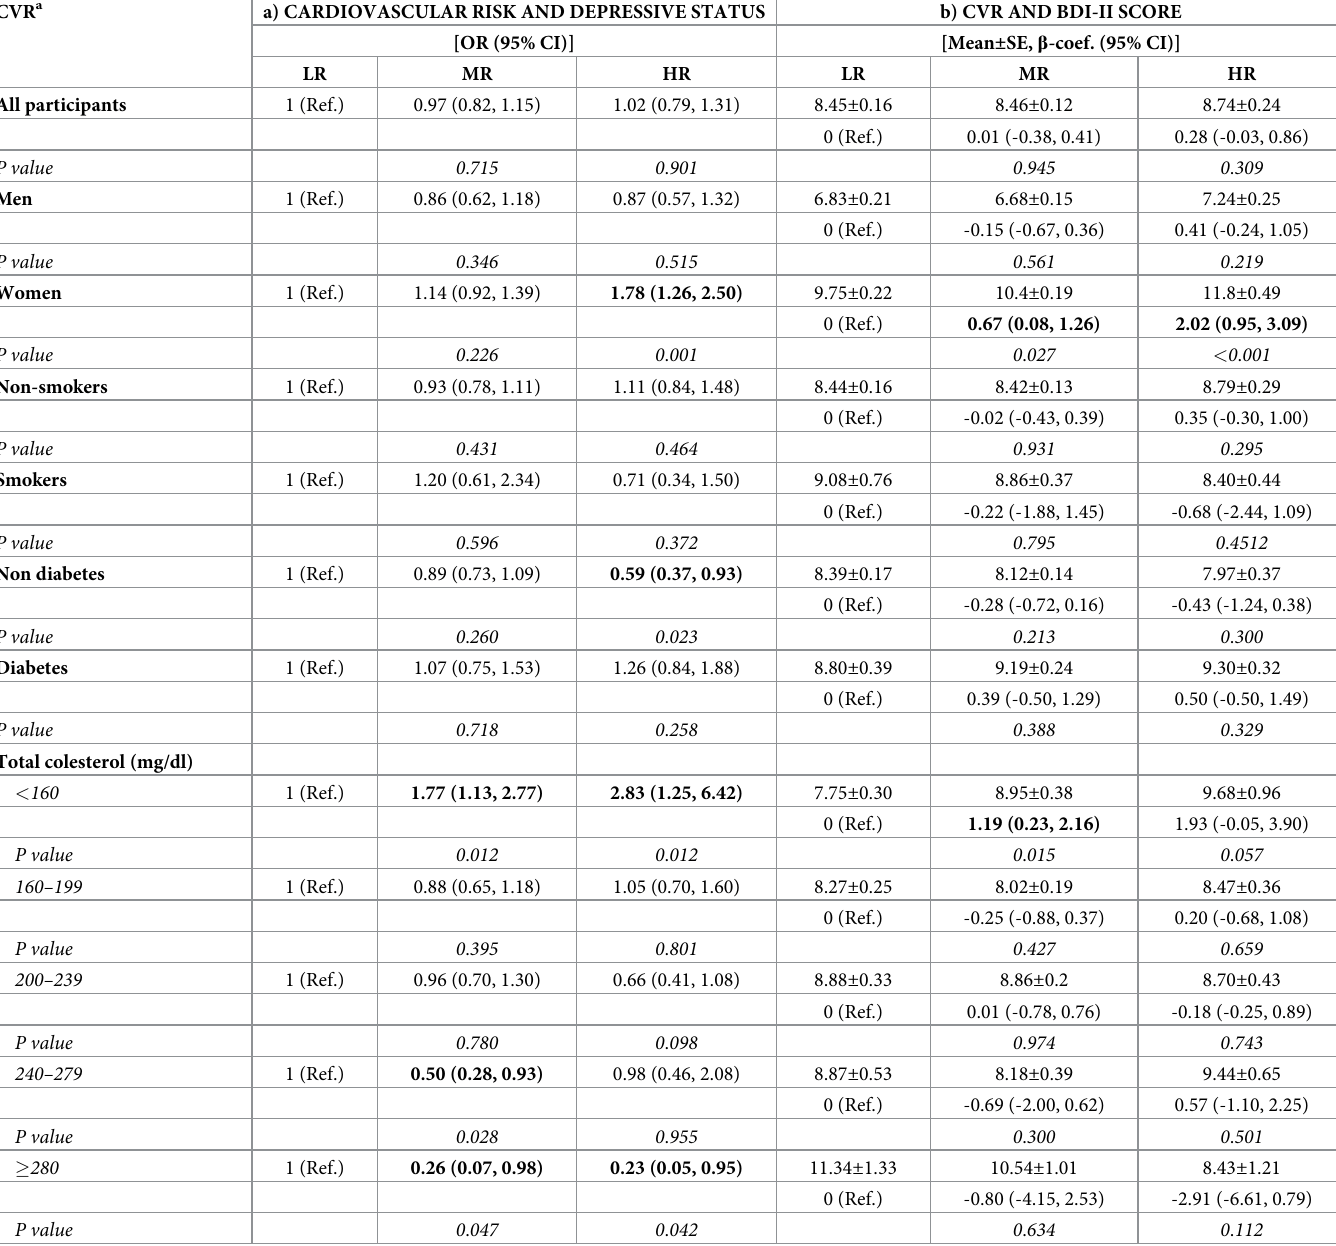
Table 3. Association between cardiovascular risk and a) depressive status (BDI-II � 18) and b) BDI-II score, in the PREDIMED-PLUS trial, stratified by CVR fac- tors, at